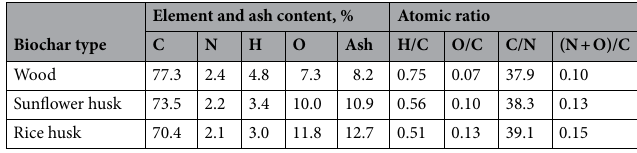
Table 1. Average elemental composition of the studied biochars.